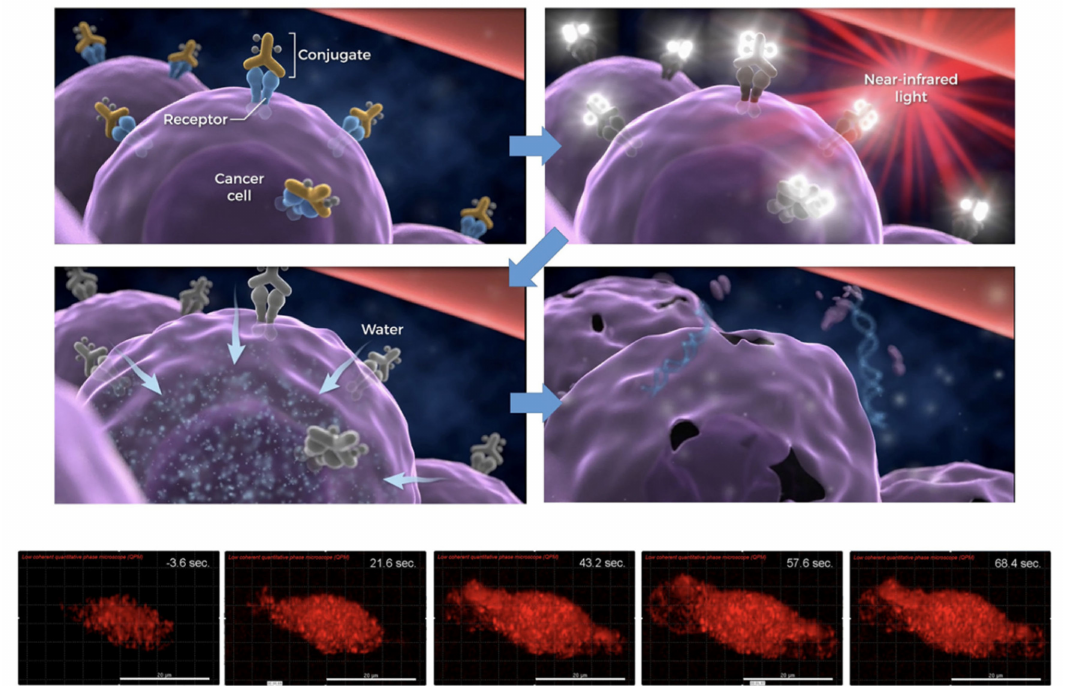
Figure 6. The diagram of near-infrared photoimmunotherapy (NIR-PIT). The targeted photosensitizer can better distinguish tumor cells therefore PIT can destroy tumor cells more selectively under the NIR laser. Reprinted permission from ref. [140]. Copyright 2019,